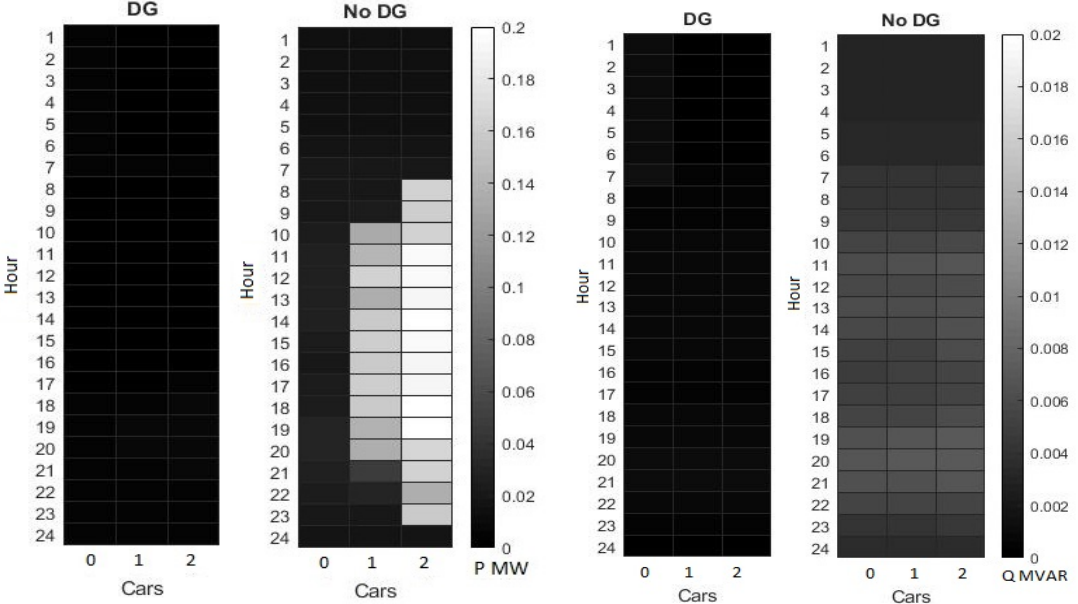
Figure 16. Total active power requirement (MW) of the entire network vs. total reactive power requirement (MVAR) of the entire network.